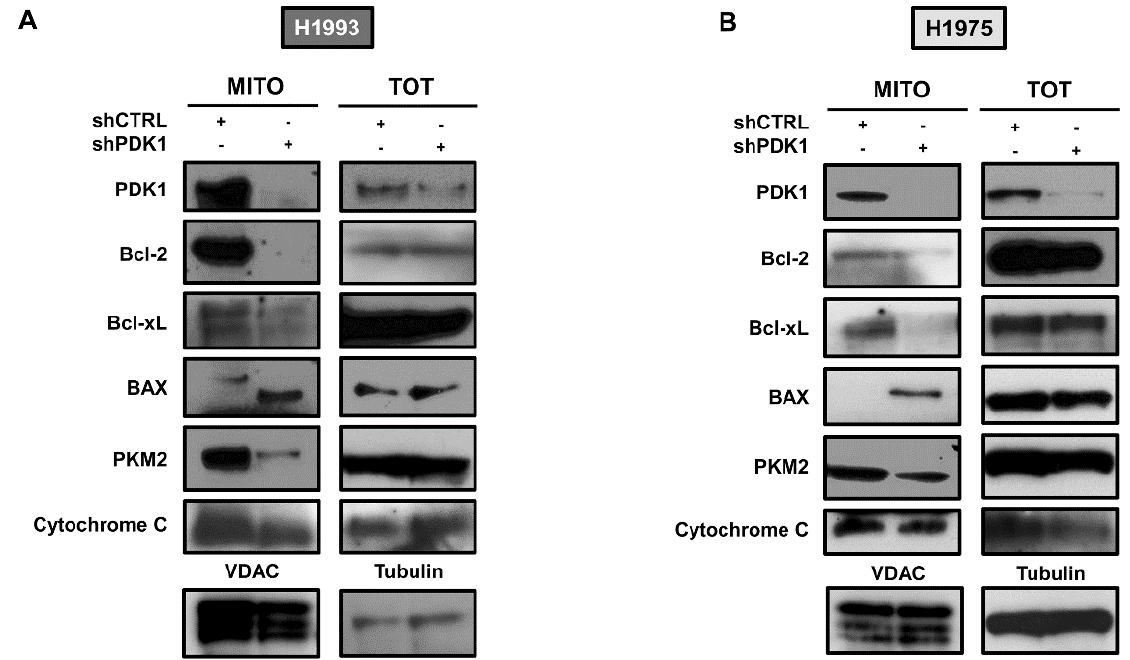
Figure 5. PDK1-dependent localization of selected proteins in mitochondrial fractions. ( A,B ) Levels of PDK1, Bcl-2, Bcl-xL, BAX, PKM2 and cytochrome C in mitochondrial fractions and whole cell lysates of shCTRL and shPDK1 H1993 ( A ) and H1975 ( B ) cells. VDAC and tubulin served to ensure equal loading. The uncropped Western Blot images can be found in Figures S23–S24.